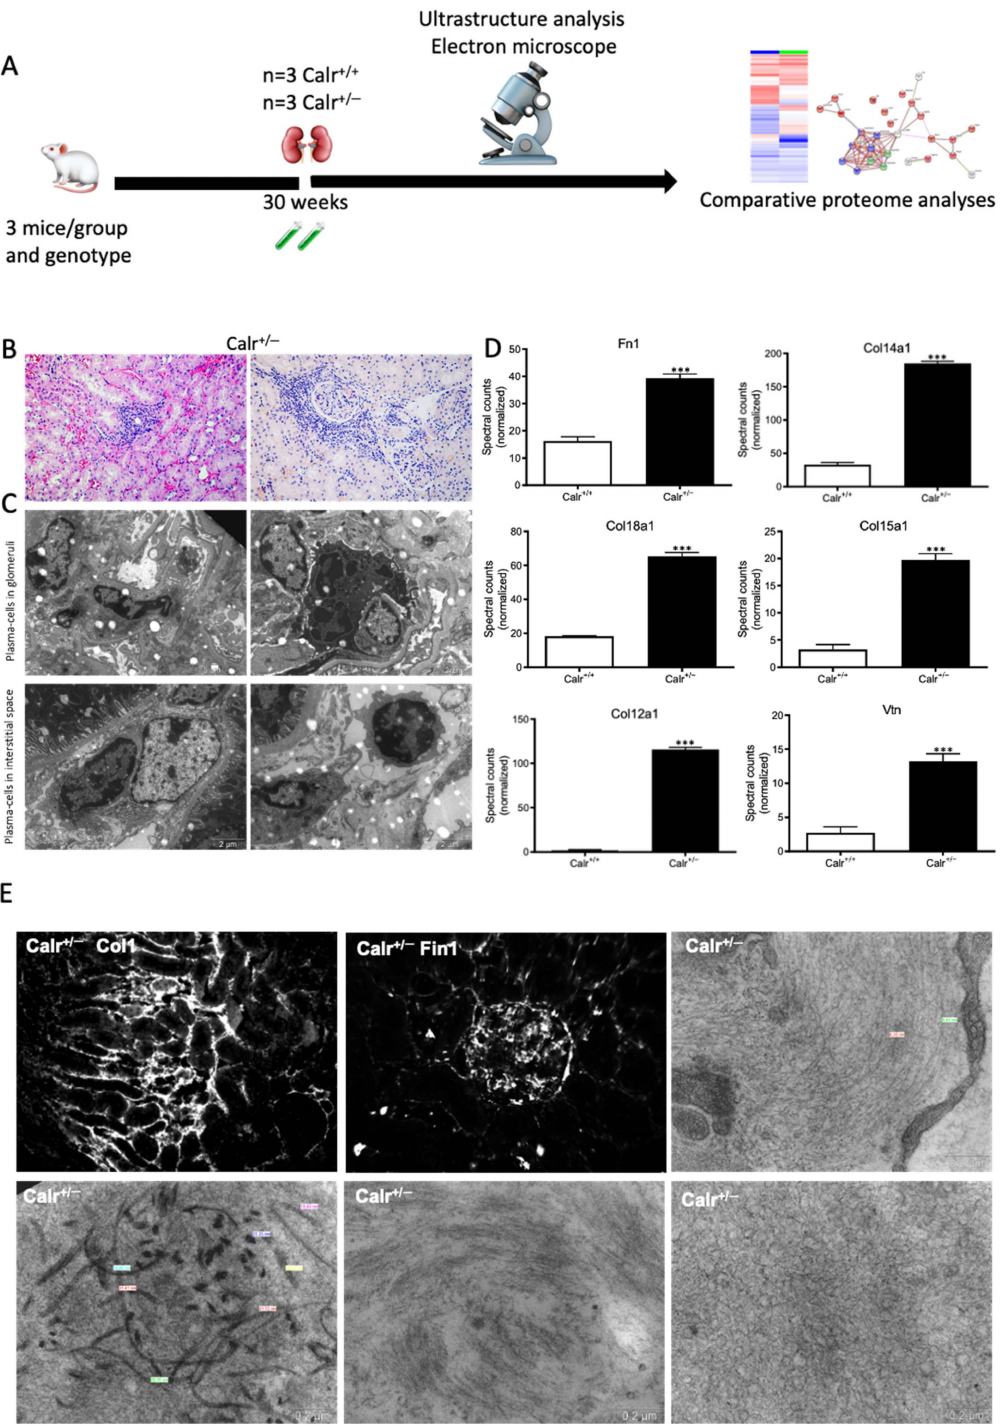
Figure 9. Blood cell infiltration and inflammation of kidney tissue in Calr +/ − mice. ( A ):